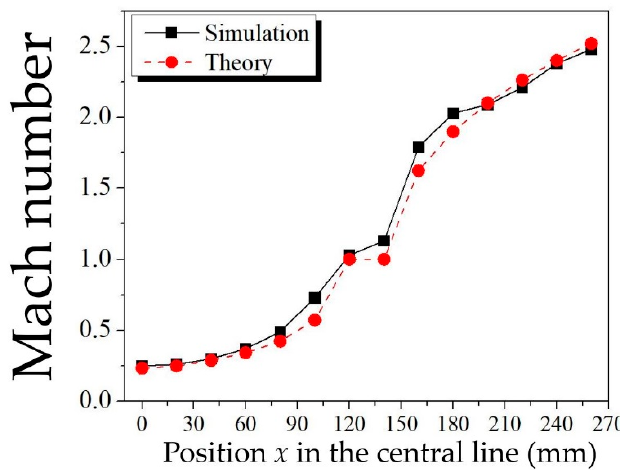
Figure 11. The Mach number ( M ) at the position x on the central line, which resulted from the sim- ulation and the theory.